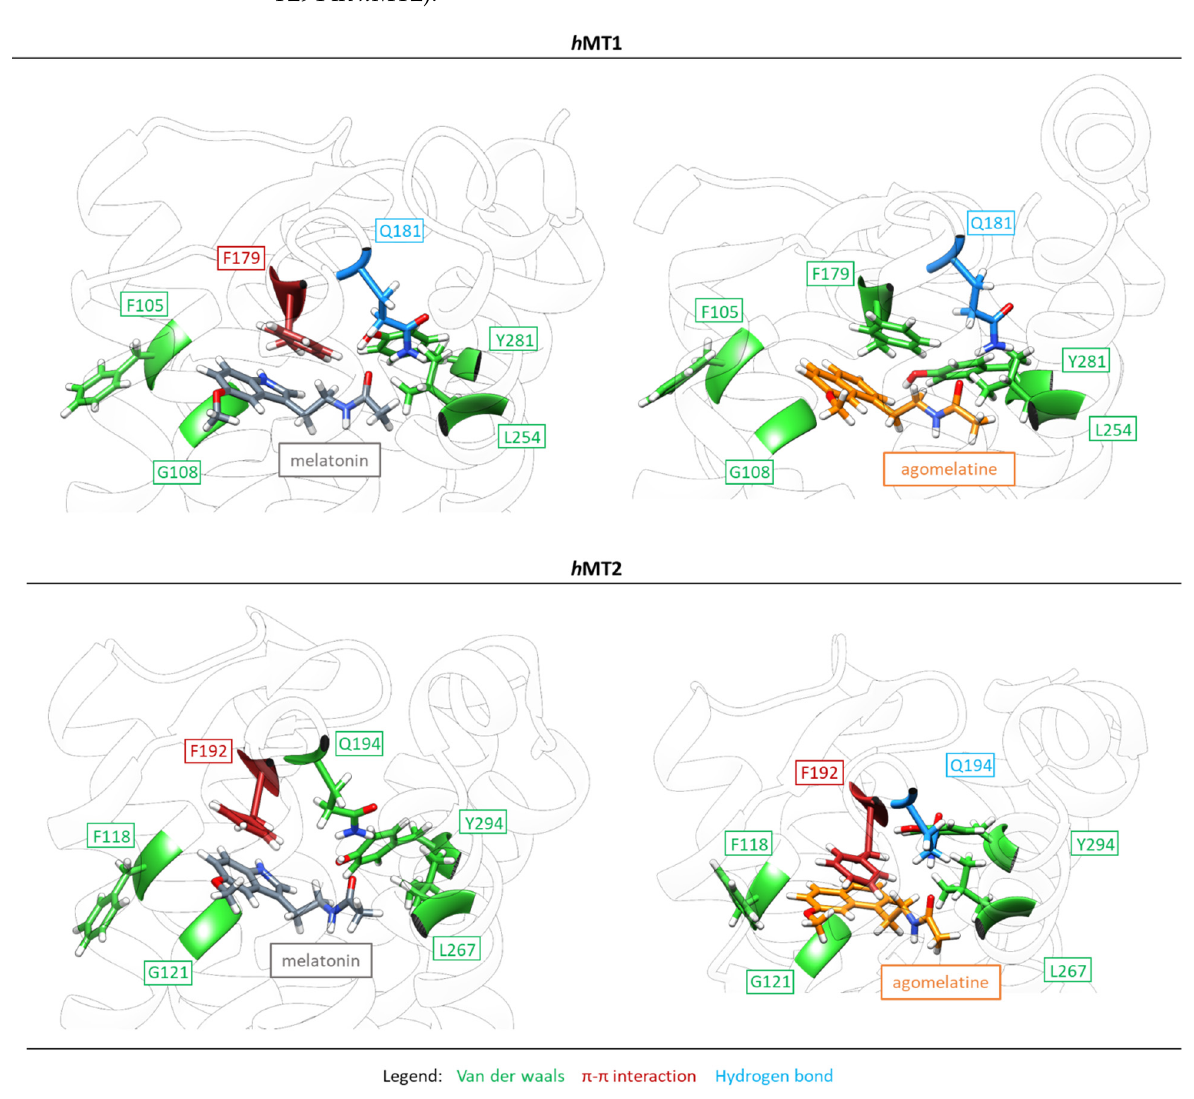
Figure 9. 3D representation of the final poses of melatonin and agomelatine in the h MT1 and h MT2 orthosteric site after 100 ns molecular dynamics simulations (docked poses starting for MD in green; final MD configuration in yellow) (for 2D mapping see Supplementary Materials Figure S3).